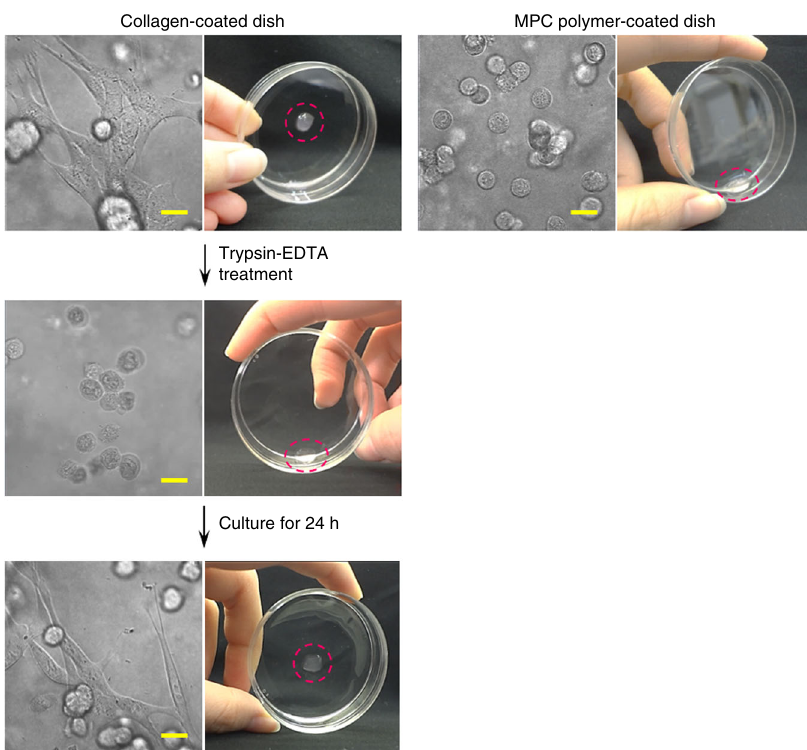
Fig. 4 CxGel adhesion to cell culture dishes via the adhesion of cells at the surface. (left panels) Photographs of CxGels, prepared through click reaction between azide-modi fi ed C2C12 cells (2.0 × 10 6 cells) and bAlg-DBCO solution (2%), adhered to collagen-coated dishes via the adhesion of cells in the CxGels. After trypsin-EDTA treatment, the adhering cells detached from the dish and the CxGels detached. The CxGels adhered onto a collagen-coated dish again when placed on the dish and cultured in DMEM for 24 h. (right panel) In contrast, since cells in the CxGels, prepared through click reaction between azide-modi fi ed C2C12 cells (2.0 × 10 6 cells) and bAlg-DBCO solution (2%), did not adhere onto MPC polymer-coated dishes, the CxGel also did not adhere onto MPC polymer-coated dishes even after 24 h. Scale bars indicate 20 μ